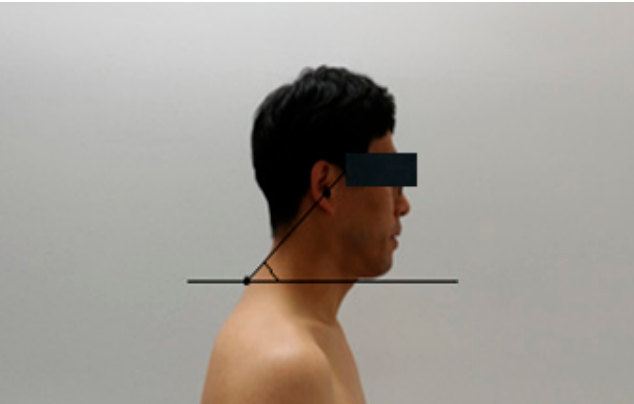
Figure 5. Measurement of craniovertebral angle.